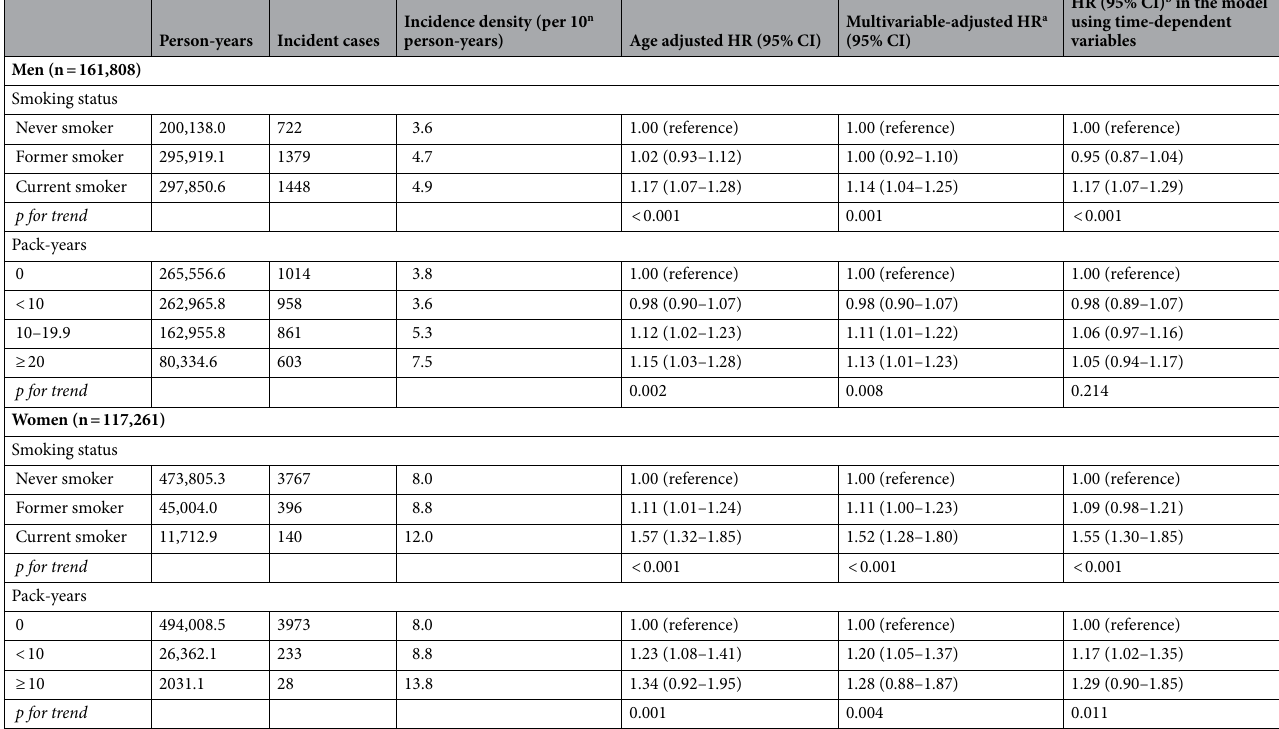
Table 3. Development of visual impairment according to smoking status and smoking pack-years. The P value for the interaction of sex and smoking status for risk of bilateral visual impairment was 0.010 (multivariable model). The P value for the interaction of sex and pack-years for risk of bilateral visual impairment was 0.098 (multivariable model). BMI body mass index, CI confidence intervals, CVD cardiovascular disease, HR